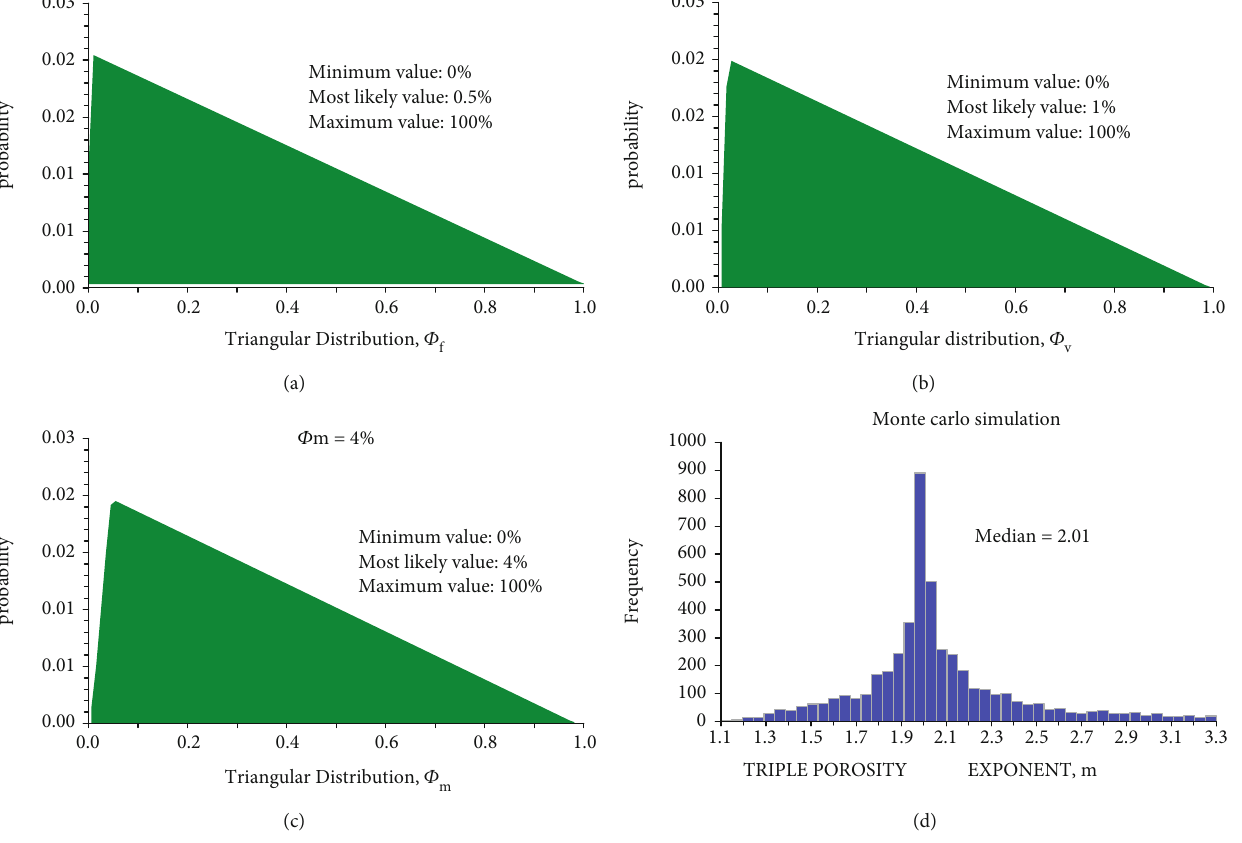
Figure 8: m value of low-porosity triple-pore medium reservoir (low-porosity carbonate rock) predicted by Monte Carlo simulation